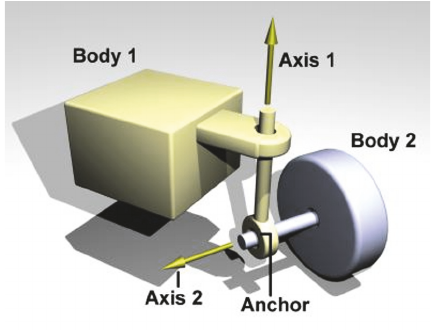
Figure 1: Hinge-2 joints